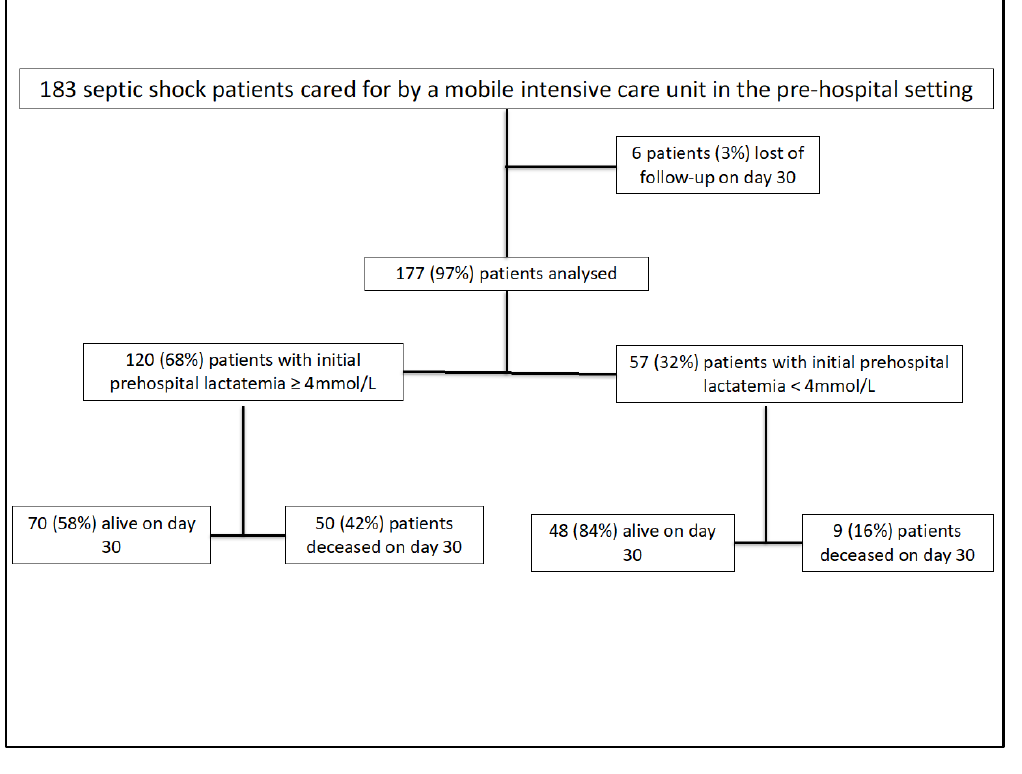
Table 1. Population characteristics.